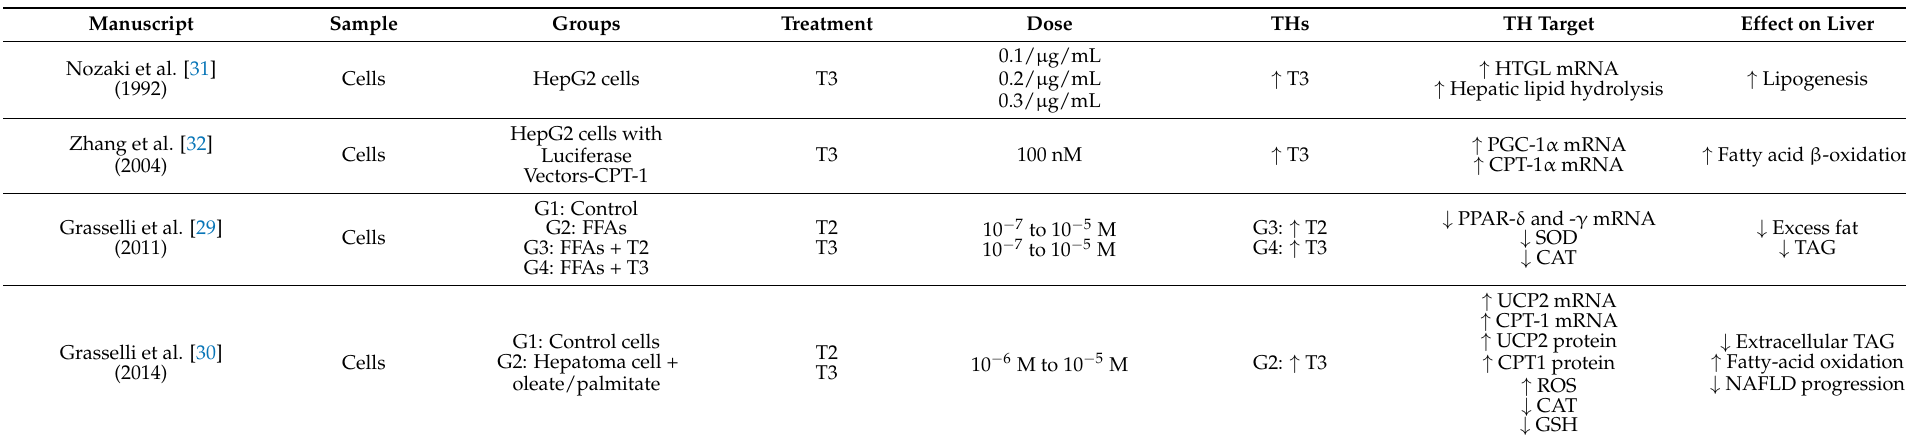
Table 3. Metabolic actions modulated by thyroid hormone signaling in experimental